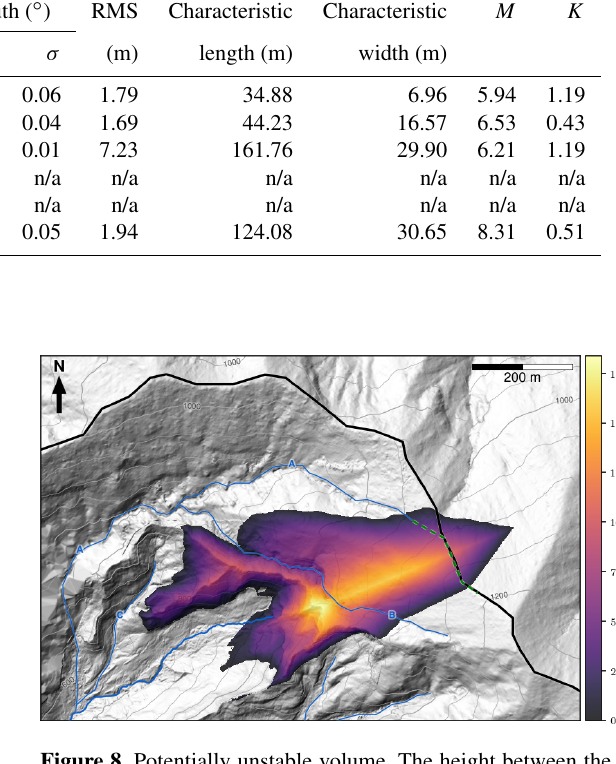
Table 2. Surfaces used for quantifying a potential unstable volume, with characteristics of the associated best-fit planes. σ is the standard deviation of estimated dip and dip directions. See Appendix A for characteristic length and width computations, as well as for the derivation of M and K . Following Fernández (2005), a good fit and reliability correspond to M ≥ 4 and K ≤ 0 . 8. n/a: not applicable. Description Dip ( ◦ ) Azimuth ( ◦ ) RMS Characteristic Characteristic